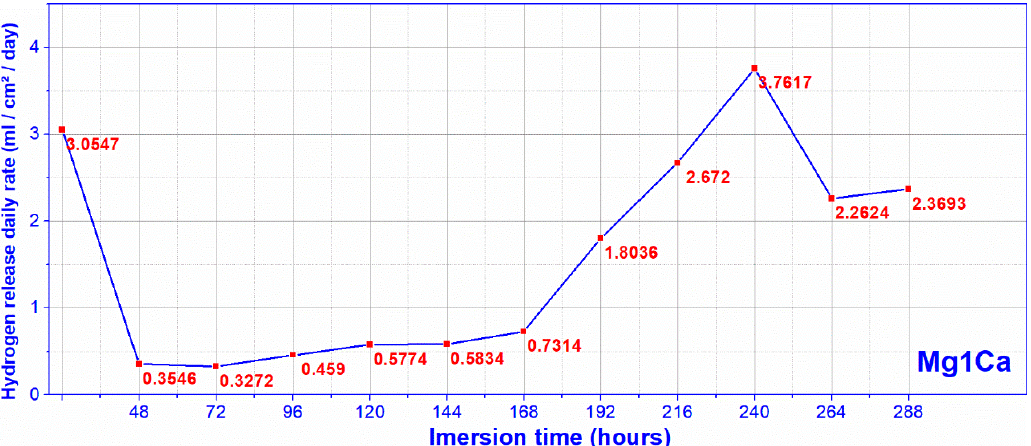
Figure 8. Hydrogen release rate, Dulbecco (mean values for three samples).